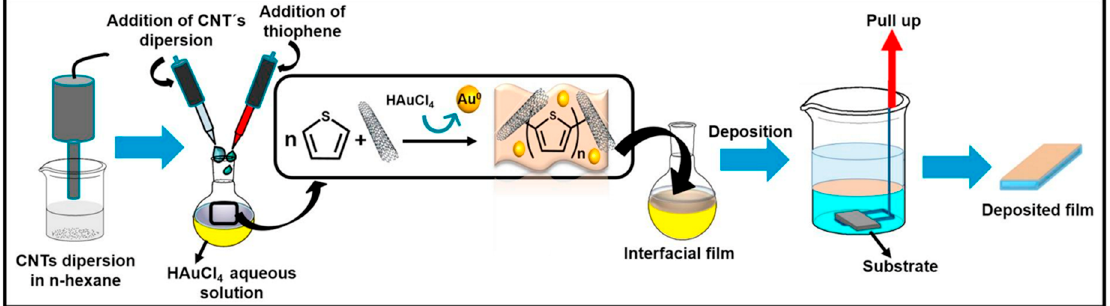
Figure 7. Schematic representation of the fabrication process of PT/Au/CNT electrodes. Reproduced with permission from [120]. Copyright 2019 Elsevier B.V.